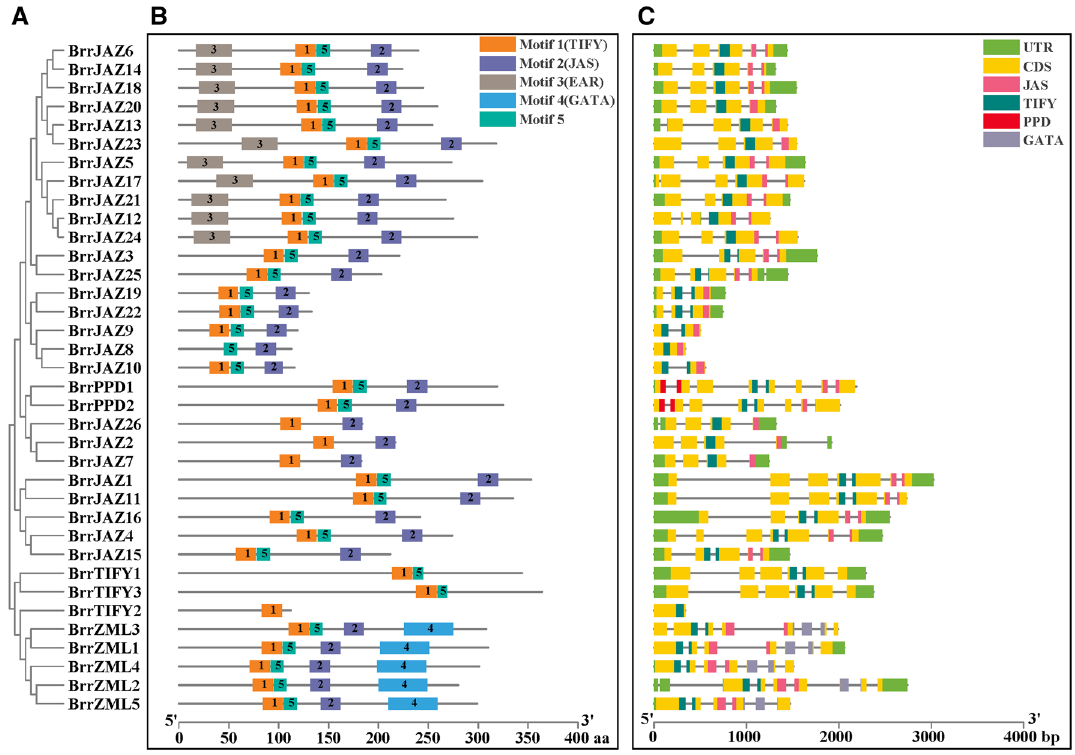
Figure 3. Gene structure, conserved motif and genetic relationship of JAZ protein in turnip. ( A ) Phylogenetic analysis of BrrJAZ proteins. The phylogenetic tree was performed in MEGA 7 with the neighbor-joining method. ( B ) The distribution of conserved motifs in BrrJAZ proteins. Each motif was represented by a colored box. ( C ) Exon/intron structure and conserved domains of BrrJAZ genes. Exons and introns were represented by yellow boxes and black lines, respectively. Each conserved domain was represented by a colored